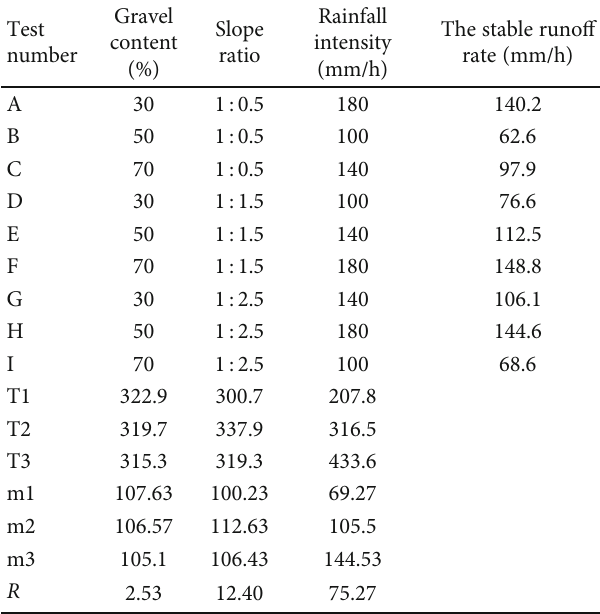
Table 2: Analysis of in fl uencing factors of runo ff rate in stable stage.